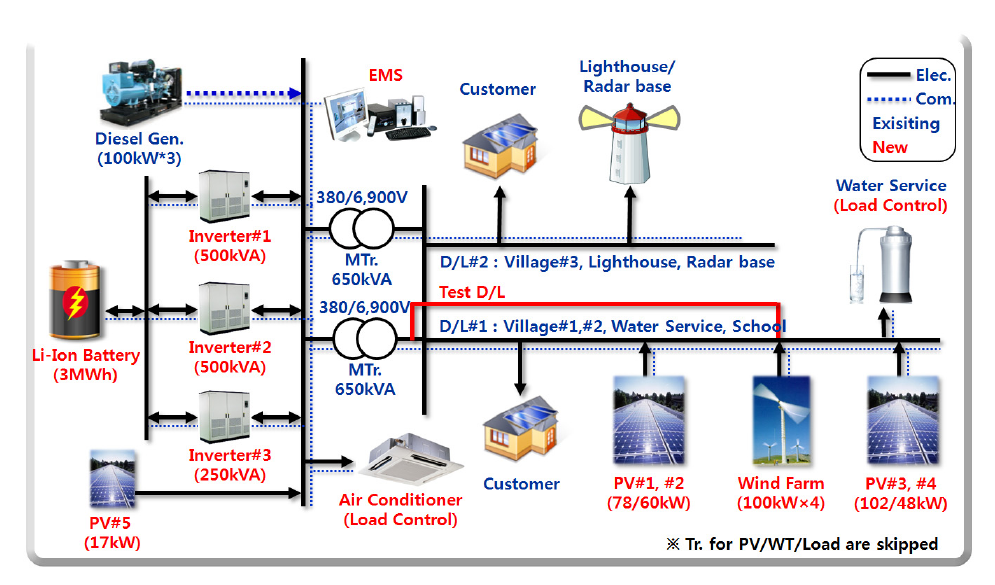
Figure 3. System architecture of the test island.